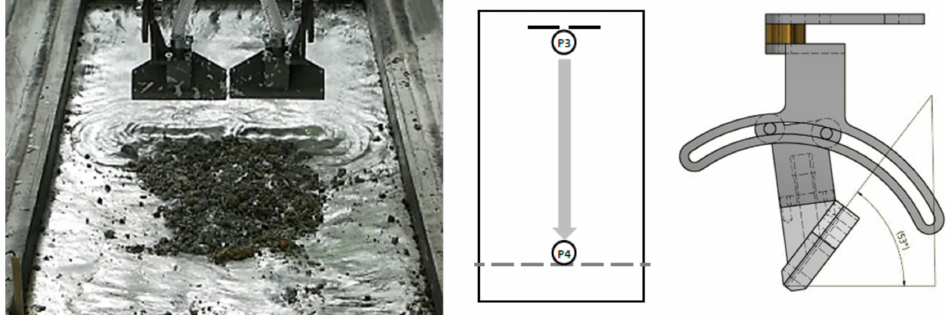
Figure 7. General efficiency of the gas-based skimming system applying linear movement with a movement rate of 0.05 m/s, nozzle angle of 53 ◦ and a parallel